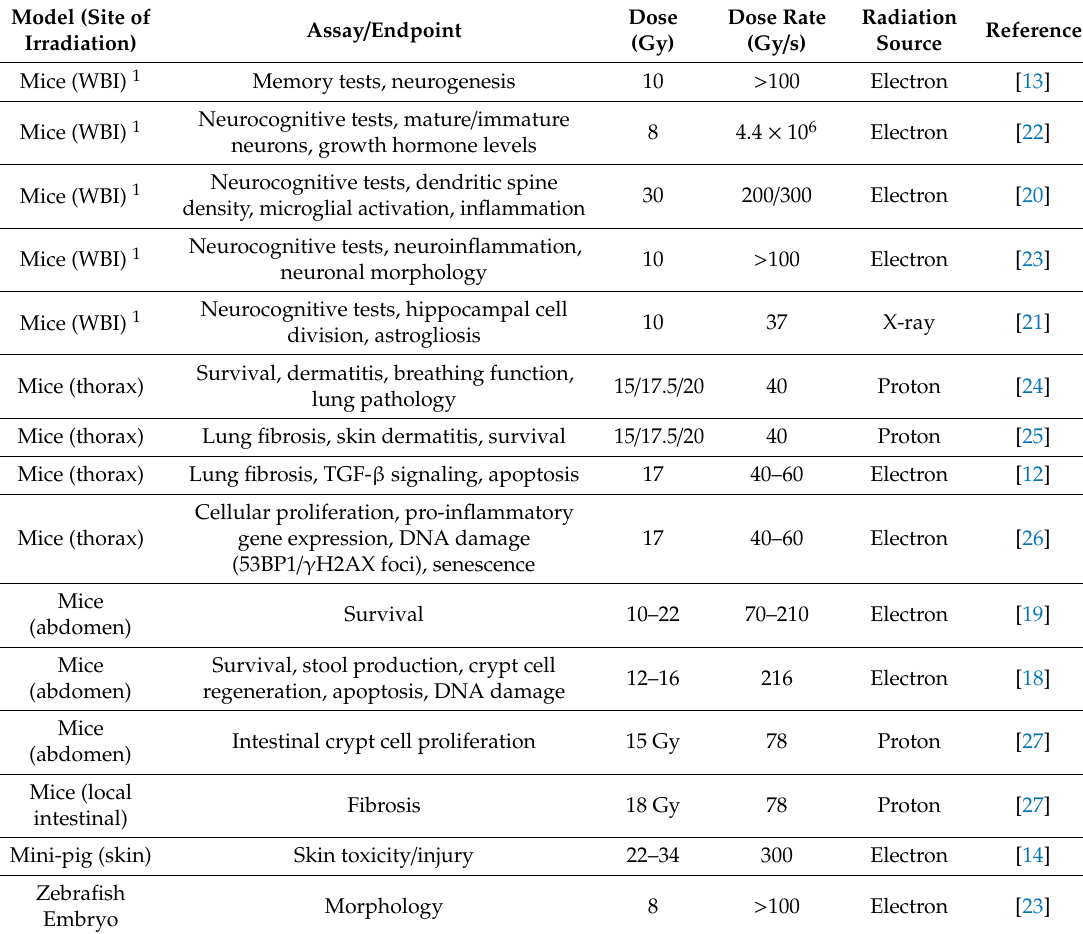
Table 1. Evidence of normal tissue sparing from FLASH